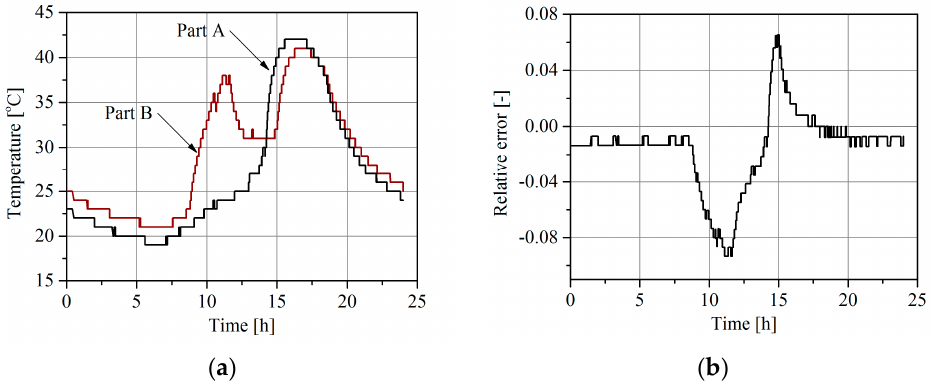
Figure 7. An example of daily temperature variations in two parts of a load sensor: ( a ) Part A—temperature of part A, Part B—temperature of part B; ( b ) relative weighing error due to different temperatures of parts A and B.